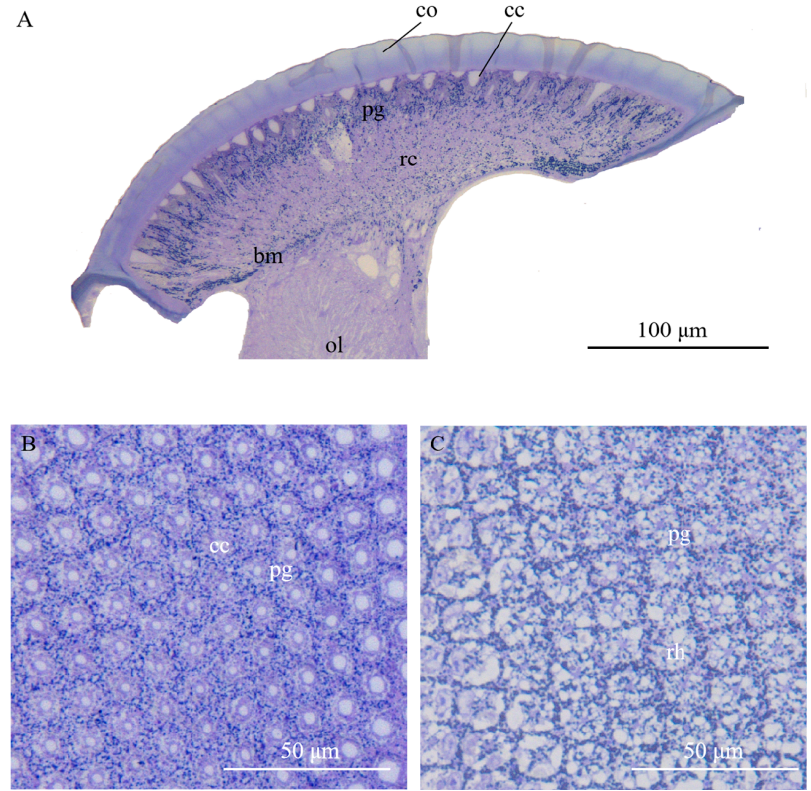
Figure 2. Light micrographs (LM) at different levels of the compound eye of Arge similis. ( A ) Longitudinal section of the compound eye in caudal-rostral direction: left to right. ( B ) Transverse section of the crystalline cones surrounded by pigment cells. ( C ) Transverse section of the retinular cell area, showing centrally fused rhabdoms and retina screening piments around the rhabdom edge and secondary pigment cell granules in peripheral positions between neighboring ommatidia. co: cornea; cc: crystalline cone; pg: pigment particles; rc: retinular cell; ol: optic lobe; rh: rhabdom; bm: basement membrane.